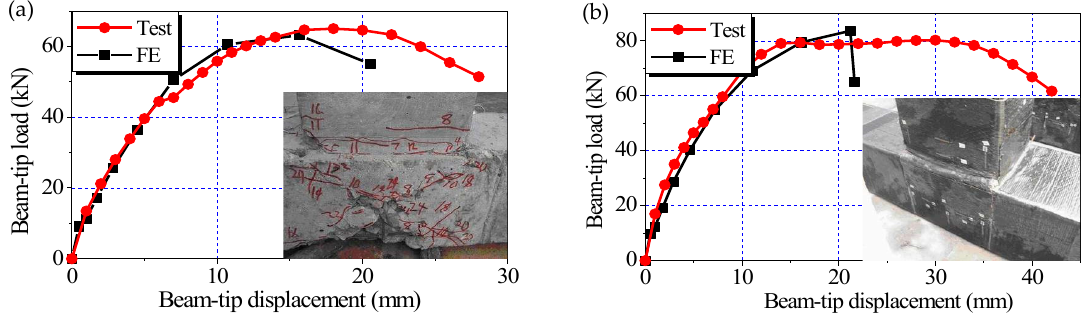
Figure 5. Comparison of the experimental and numerical load-displacement curves. ( a ) Specimen TJ-1; ( b ) Specimen TJ-3.